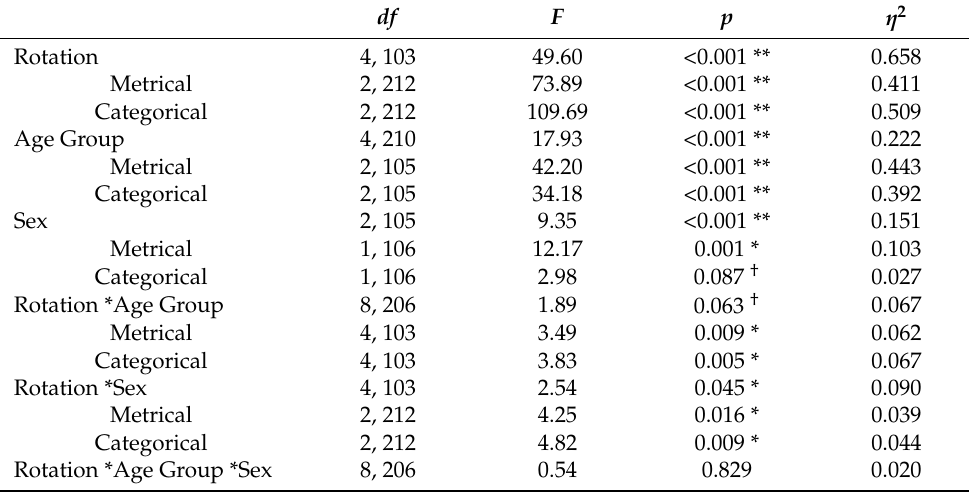
Table 2. Repeated measures MANOVA on